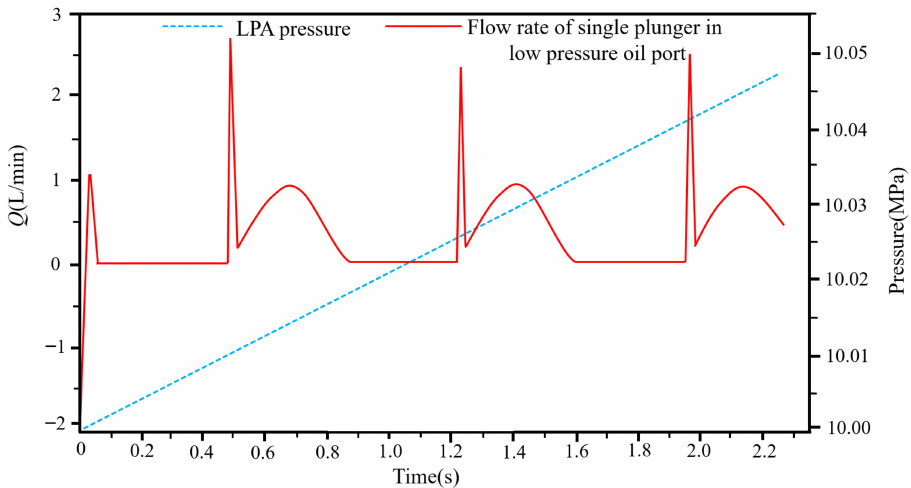
Figure 8. Diagram of LPA pressure and single plunger flow rate at low pressure oil port on motor